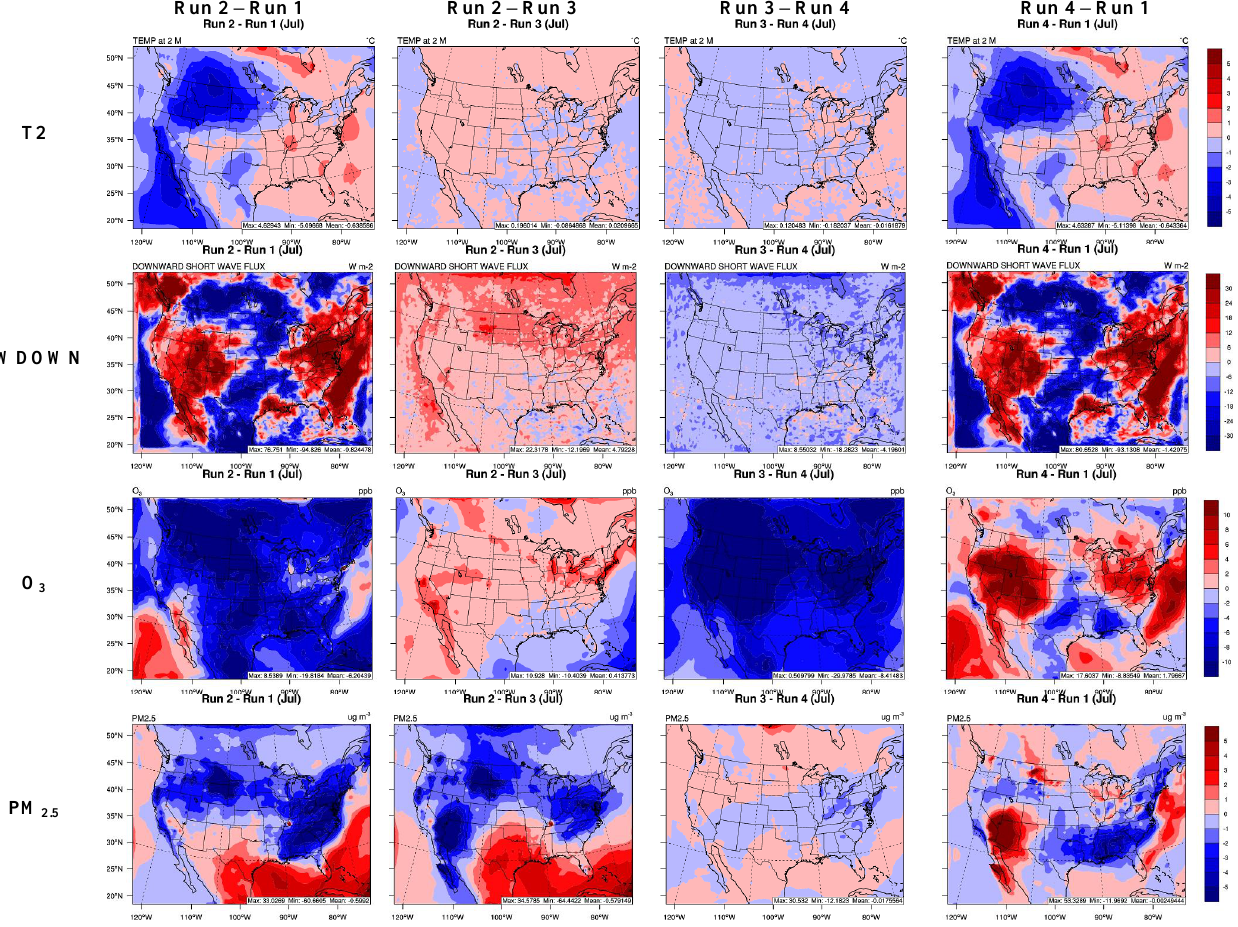
Figure 14. Spatial difference plots for July. Run 1: 2006 baseline simulations; Run 2: 2010 baseline simulations; Run 3: 2010 simulations with 2006 emissions and 2010 meteorology and chemical ICONs/BCONs; Run 4: 2010 simulations with 2006 emissions and 2006 chemical ICONs/BCONs and 2010